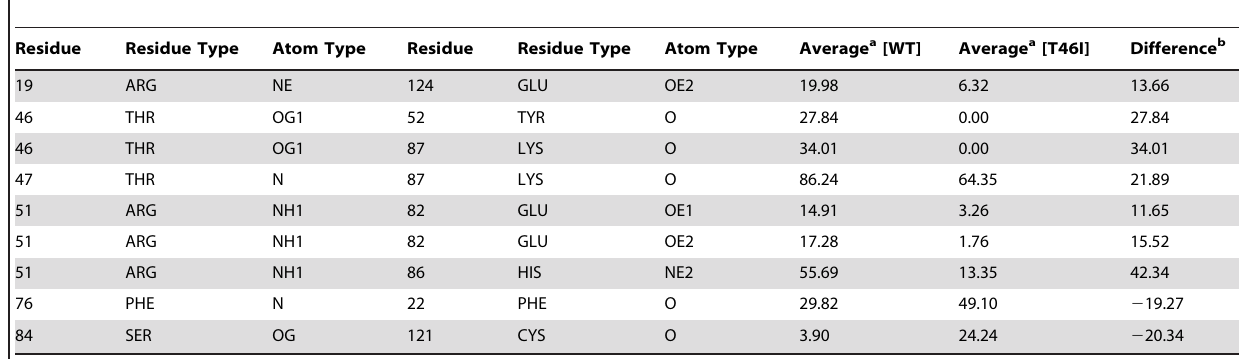
a. The displayed values of the hydrogen bond occupancy are averaged over two independent simulations with 15 ns for WT- [wild-type] and T46I-MSP domains respectively. b. Only hydrogen bonds with the occupancy difference between WT and T46I . 10% are displayed in this table.